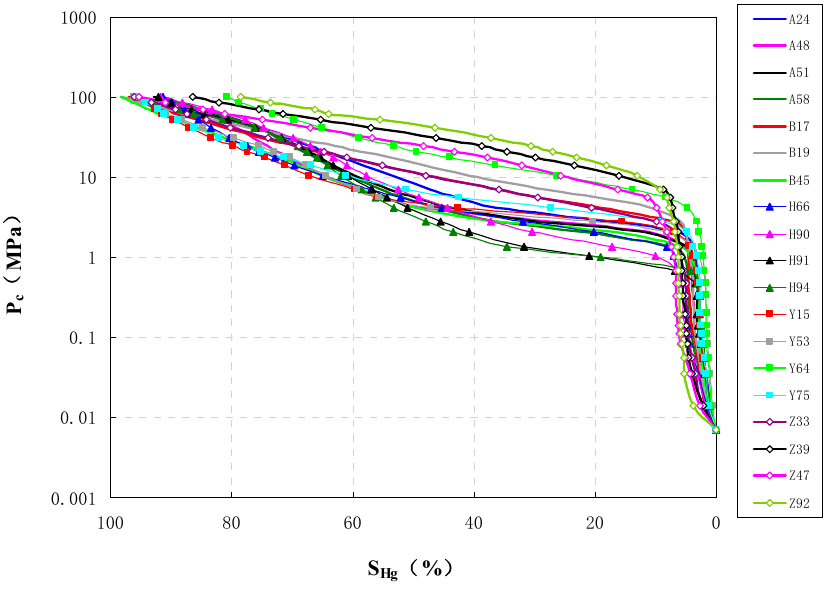
Figure 3. Mercury intrusion capillary pressure curves of 19 core plugs. 138